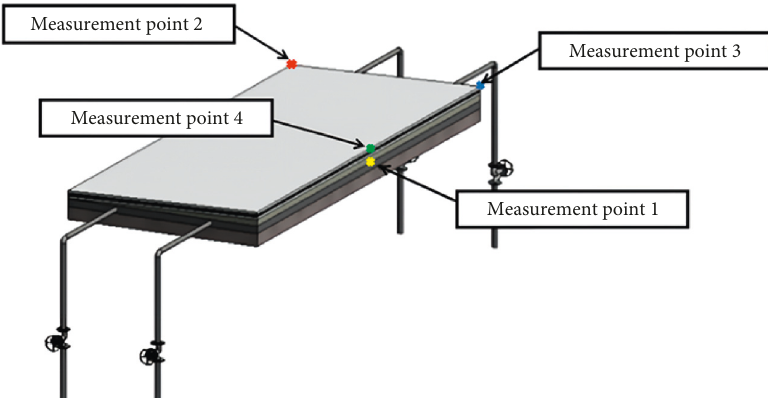
Figure 3: Temperature measurement point layout.